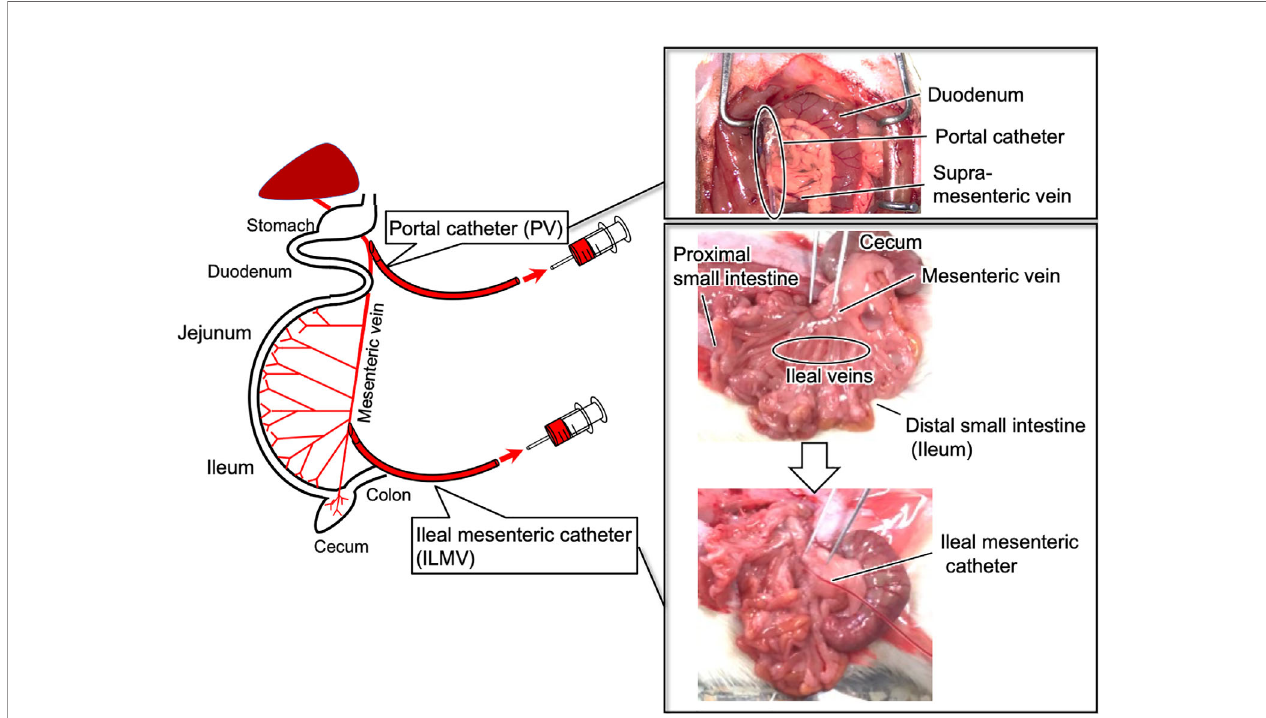
FIGURE 1 | Summary of cannulation into the ileal mesenteric vein and the portal vein in